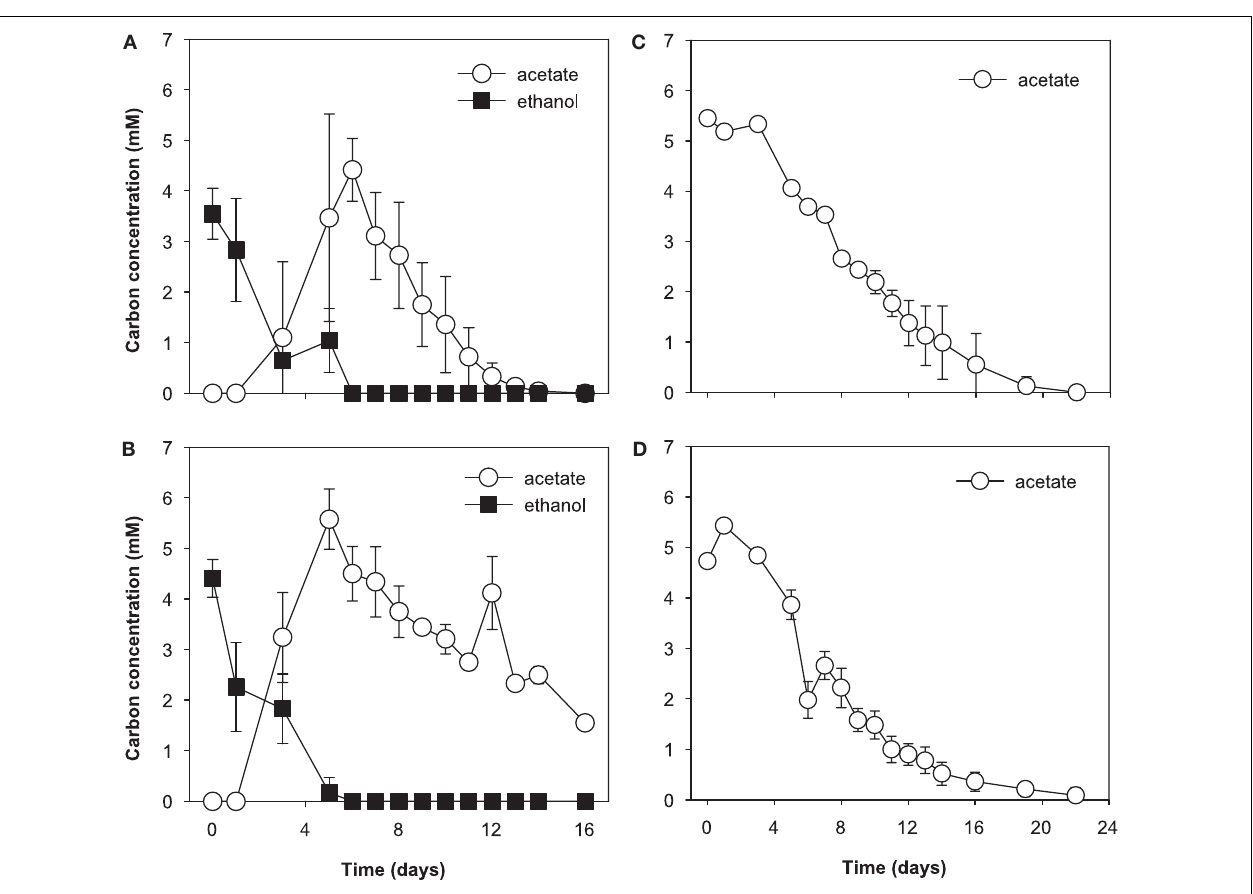
FIGURE 3 | Electron donor utilization biostimulated microcosms. (A) Ethanol only treatment, (B) ethanol with molybdate, (C) acetate-only, and (D) acetate with molybdate; molybdate was added as a sulfate reduction inhibitor. Data are means ± standard deviations of triplicate microcosms.